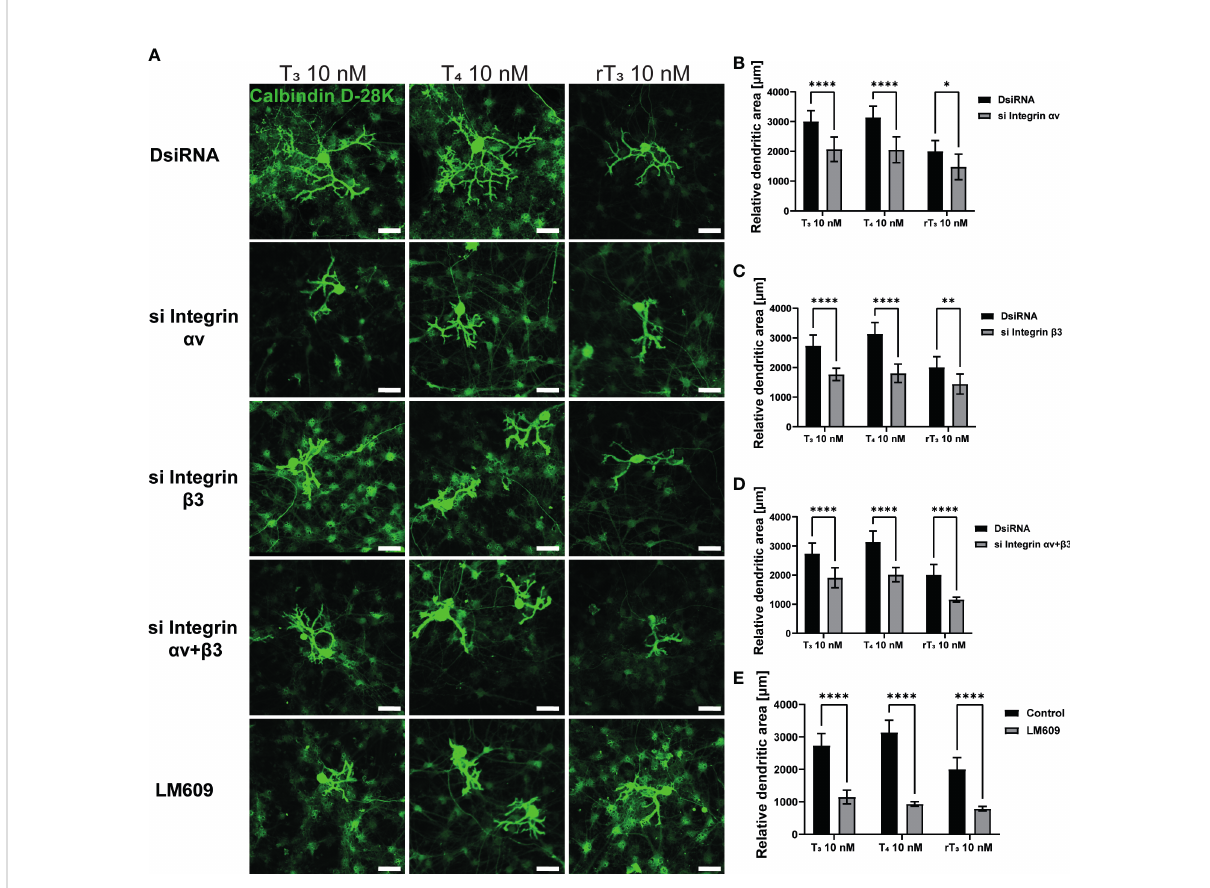
FIGURE 3 Integrin a v b 3 affected the TH-augmented dendrite arborization of Purkinje cells. Cerebellar cells were cultured for 17 days, followed by an immunocytochemistry analysis with Calbindin D-28K (green). (A) Representative photomicrographs showing the effects of TH on the morphology of Purkinje cells after integrin a v or/and b 3 knockdown or LM609 treatment. Quantitative analysis of the effect of TH after exposure to integrin av siRNA (B) , integrin b3 siRNA (C) , integrin av and b3 siRNA (D) , and LM609 2 m g/mL (E) on dendritic areas of Purkinje cells following TH treatment. ImageJ Fiji software (NIH) was used to quantify the dendritic area of Purkinje cells. Bars indicate 50 m m. Data are shown as the mean ± SEM and representative from at least three independent experiments. **** p < 0.0001, ** p < 0.01 and * p < 0.05, indicate statistical signi fi cance according to two-way or one-way ANOVA continued with post hoc Turkey test. See Supplementary Table